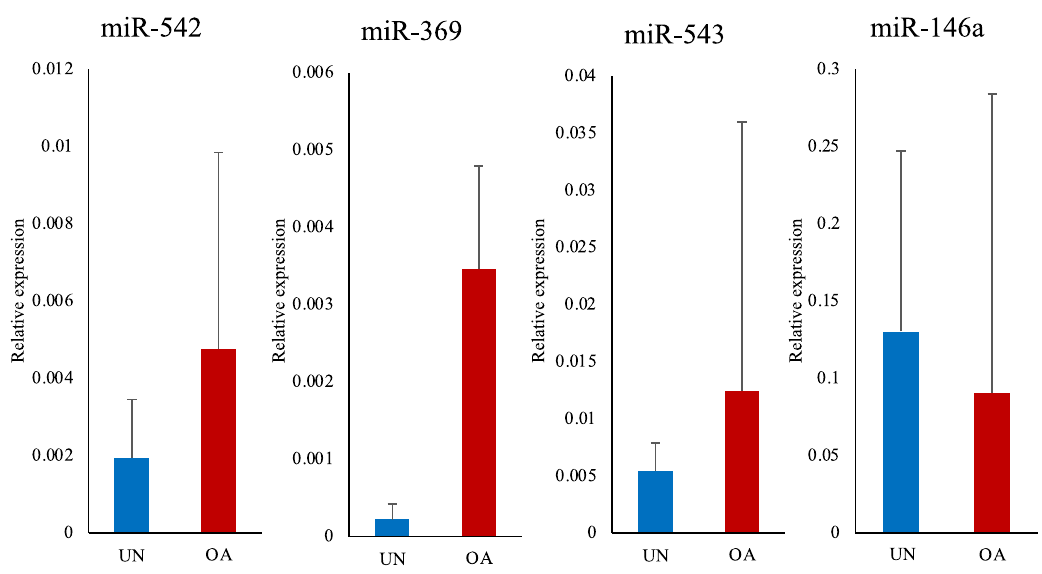
Figure 8. Comparison of miRNA expression level in the serum between the two groups. The relative expression levels of each miRNA in the serum in the osteoarthritis (OA) group and the unaffected group were compared. The data are presented as mean ± standard deviation. UN, unaffected group; OA, osteoarthritis group. *: Mean values differ significantly between the groups ( p <